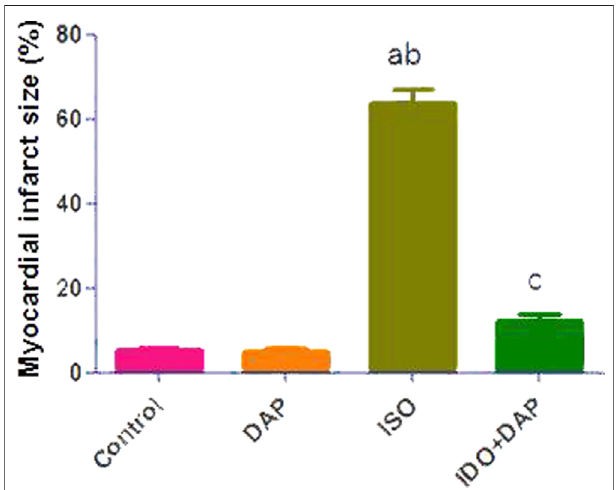
FIGURE 1 | Effect of DAP on myocardial infarct size. Data show the mean ± SEM( n (cid:1) 7). DAP: dapsone; ISO: isoproterenol. a Signi fi cant( p < 0.05)